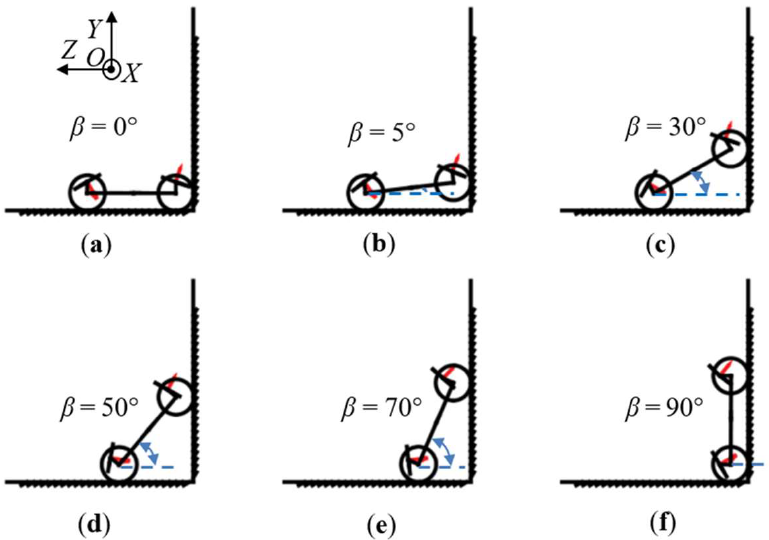
The red vectors represent the reverse thrust provided by the front and rear rotor units, F s 1 and F s 2 , respectively, and the blue angle indicates the robot pitch angle β . Based on above, the robot’s ground-wall internal transition motion strategy is designed, as shown in Figure 6.